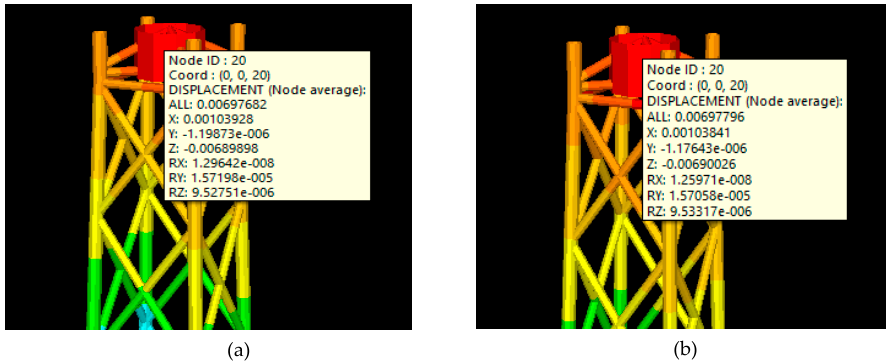
Figure 7. Comparison of nodal displacements for spatial convergence. ( a ) Displacements at the interface node of the original model. ( b ) Displacements at the interface node of the super-element model.